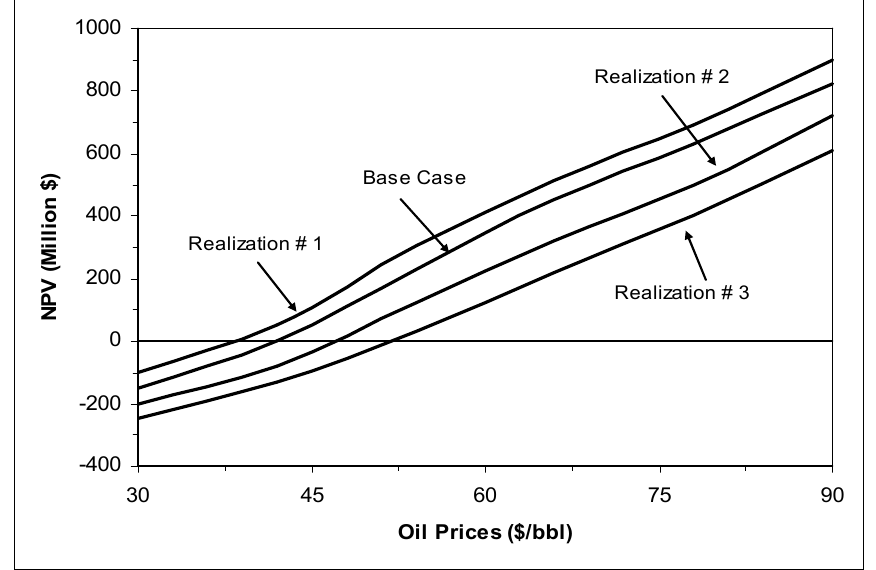
Figure 6. Variation of NPV with oil price under various permeability